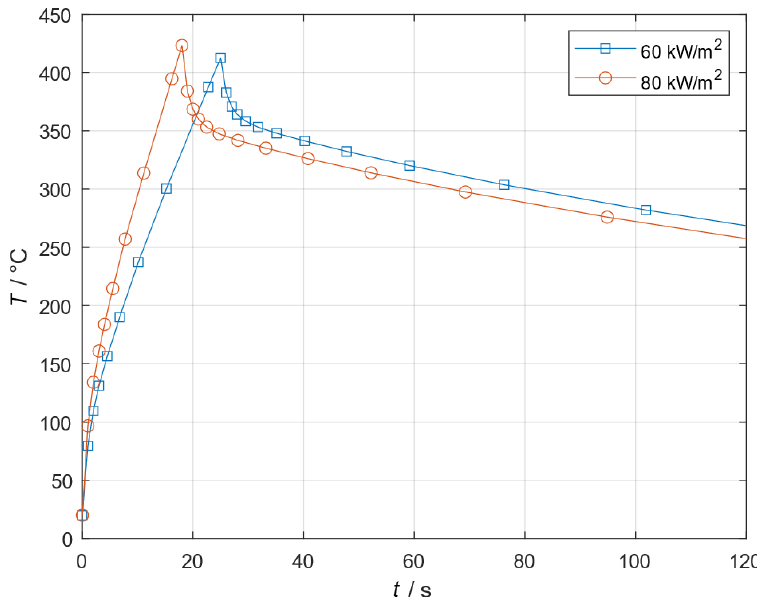
Figure 5. Welding temperature in joining zone for different input power levels at P1.